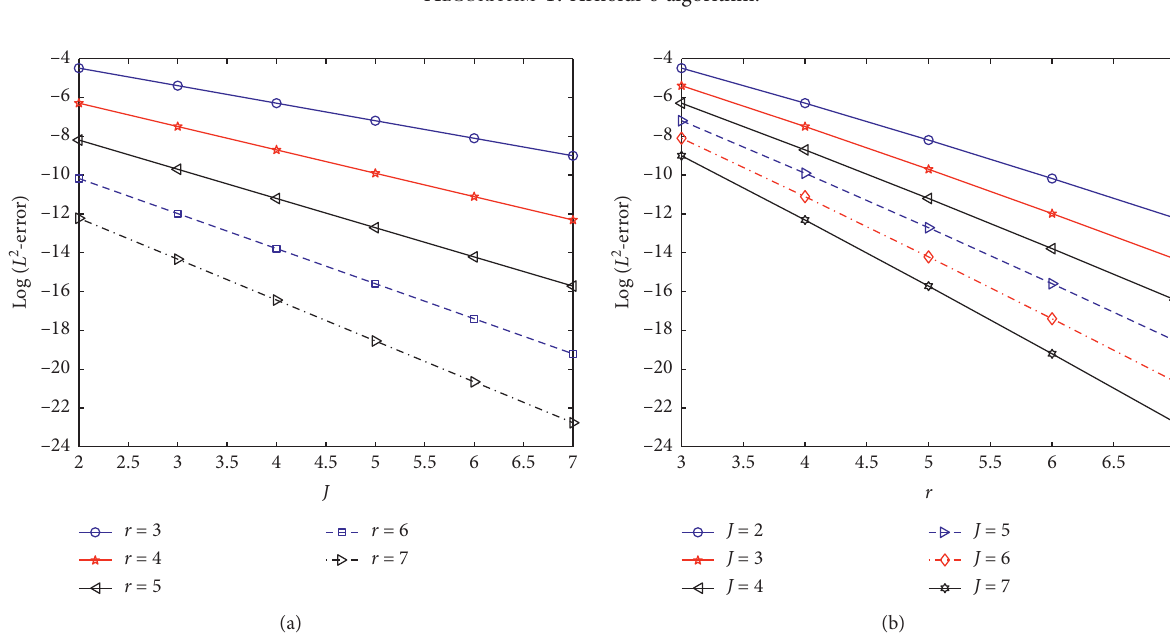
Figure 1: Effects of the refinement level J and multiplicity parameter r for Example 1.